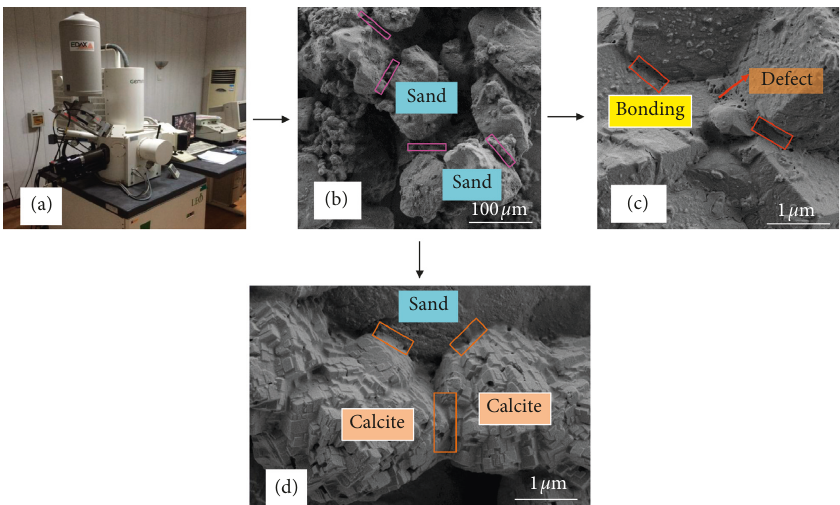
Figure 1: The microstructure of the microbial cemented sand structure observed by scanning electron